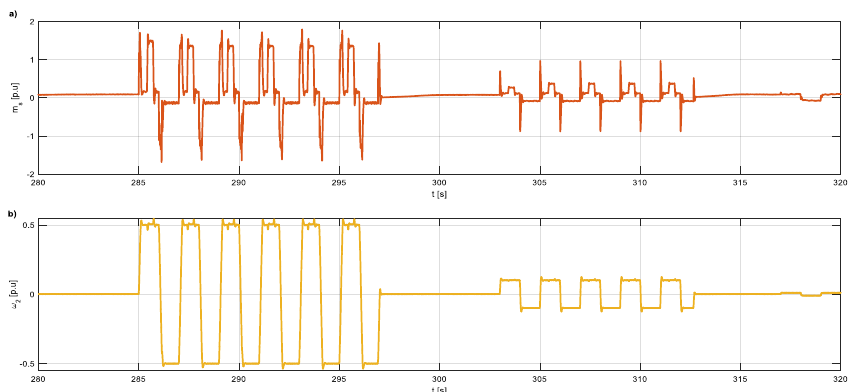
Figure 12. Operation of the applied function block: ( a ) torsional torque, ( b ) load speed.